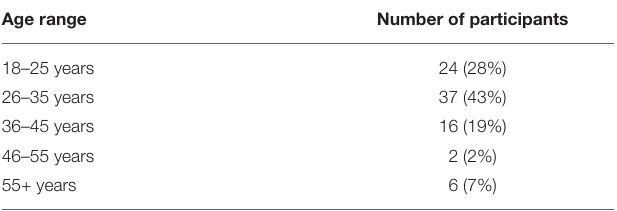
TABLE 1 | The age range of the participants of the survey ( n = 85).